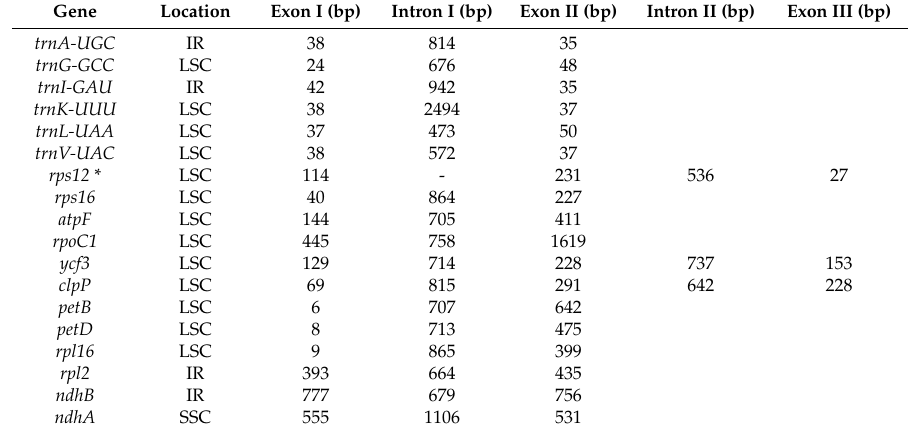
Table 2. Genes with introns within the F. suspensa chloroplast genome and the length of exons and